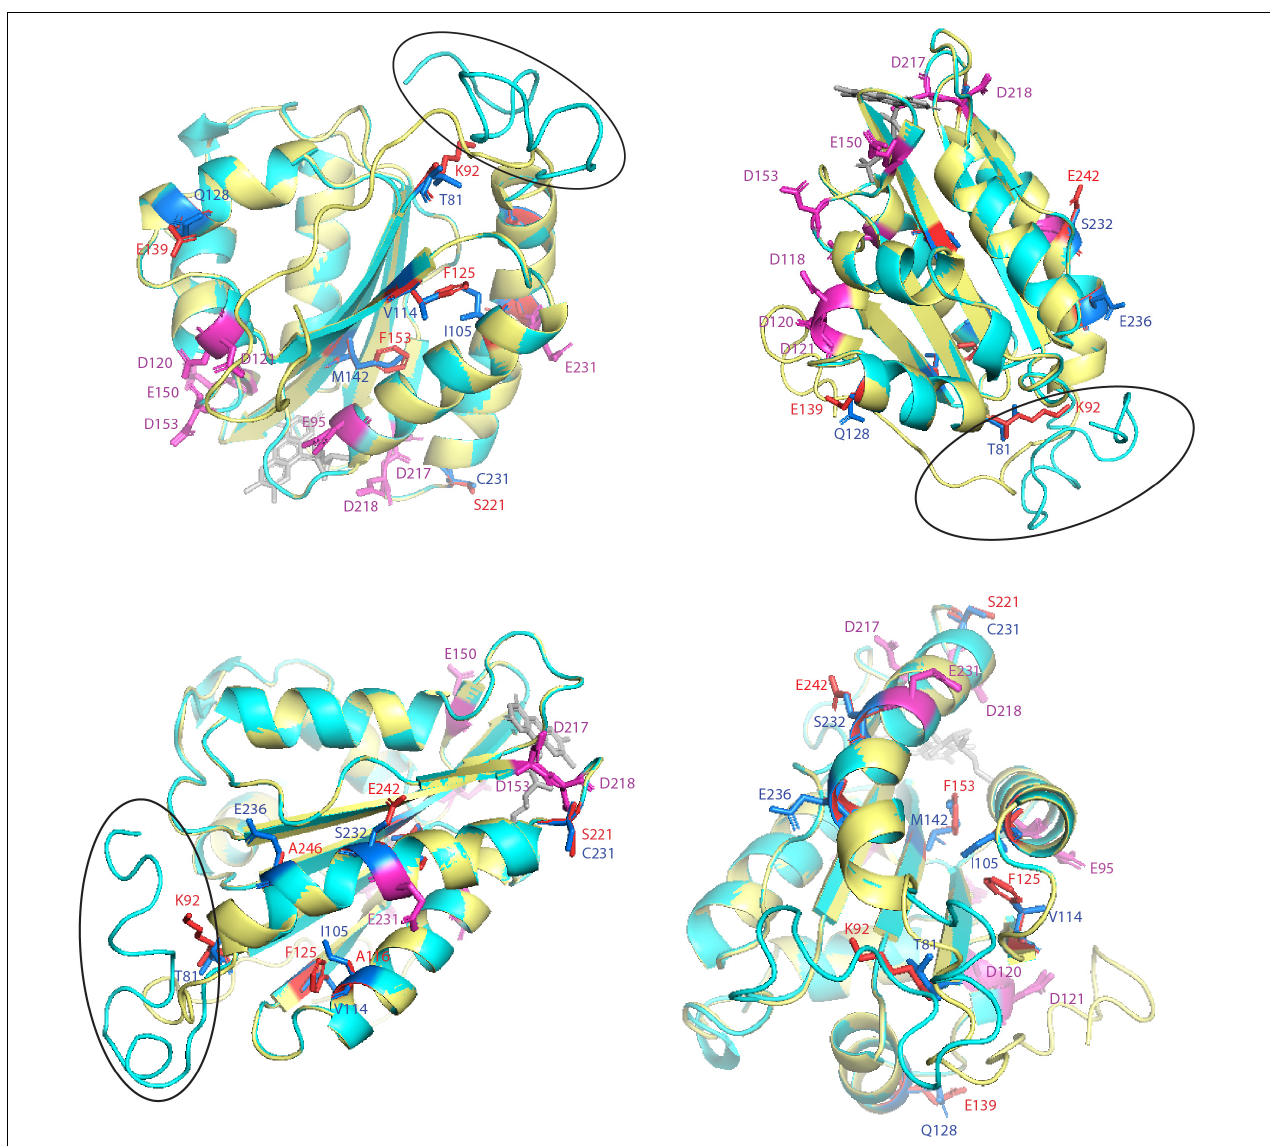
FIGURE 4 | Structural analysis of key amino acid residues in the FMN-domain of MtCPRs model from four different angles. FMN-domain of MtCPR1 is colored in yellow and MtCPR2 in cyan. Specific residues are depicted as stick with the following color code: magenta for acidic residues formerly indicated to be involved in CPR:CYP interactions, blue for key residue in MtCPR1, and red for key residue in MtCPR2. The FMN molecule is colored in gray. Black circle indicates the FMN-FAD